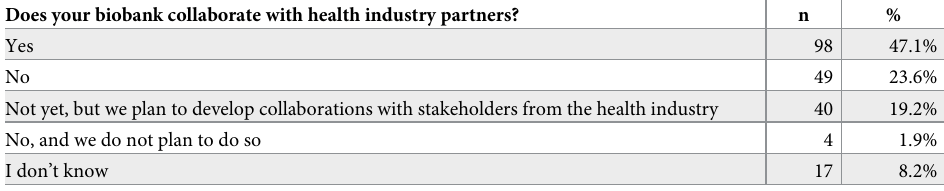
Table 12. Collaboration between biobank and health industry partners. Does your biobank collaborate with health industry partners?